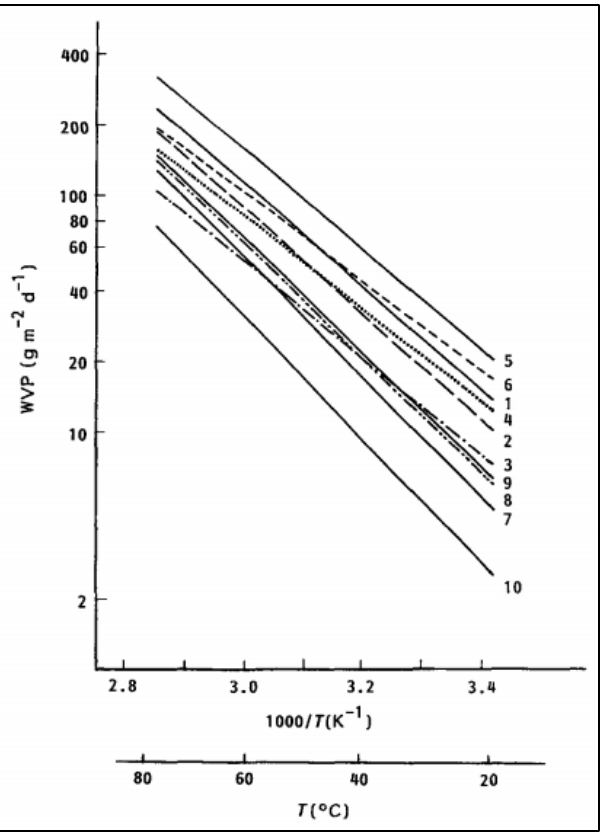
Figure 6. Arrhenius Plot for the Water-vapor Permeabilities of Insulating Glass Sealants [14].